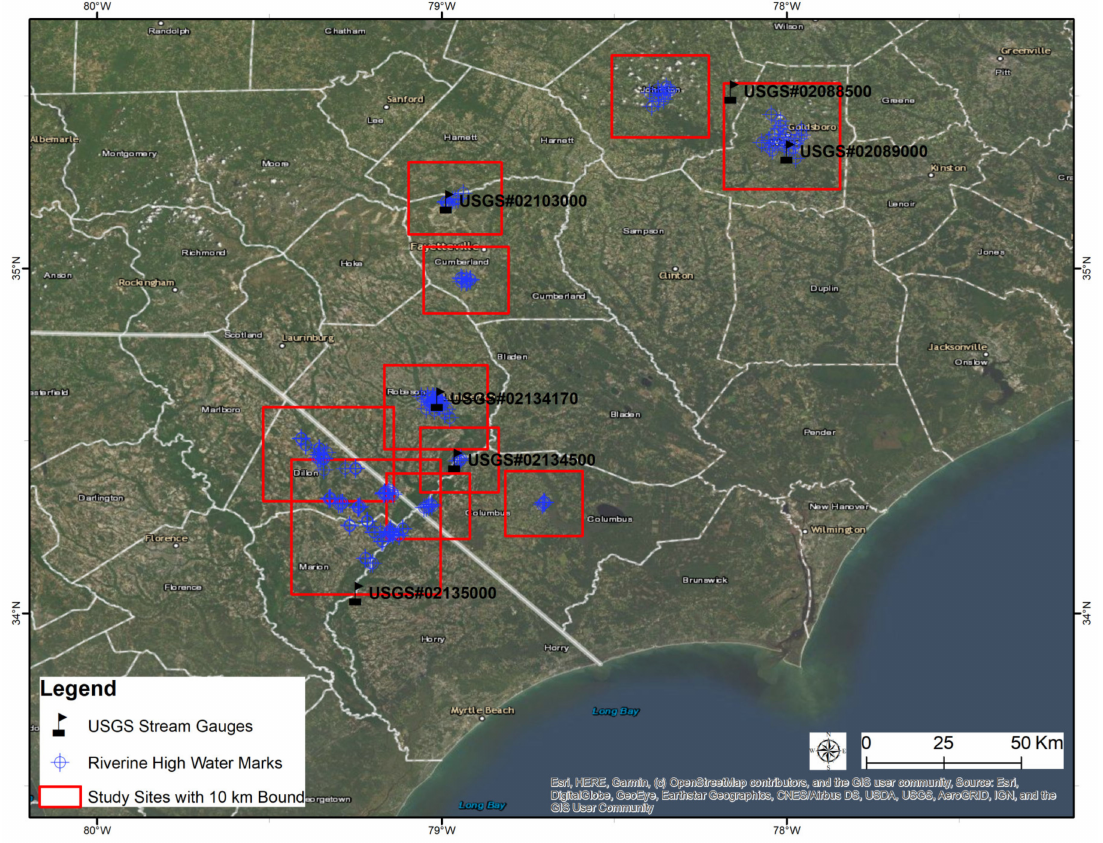
Figure 1. Study sites with the 10 km long rectangular bound centered on the 10 clusters of riverine high water